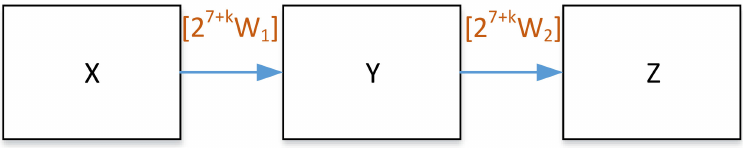
Figure 4. Forward propagation using clipping-based post-training quantization.